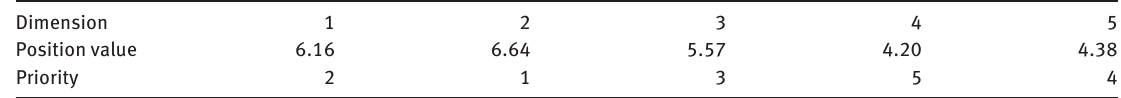
Table 2: Solution Coding and